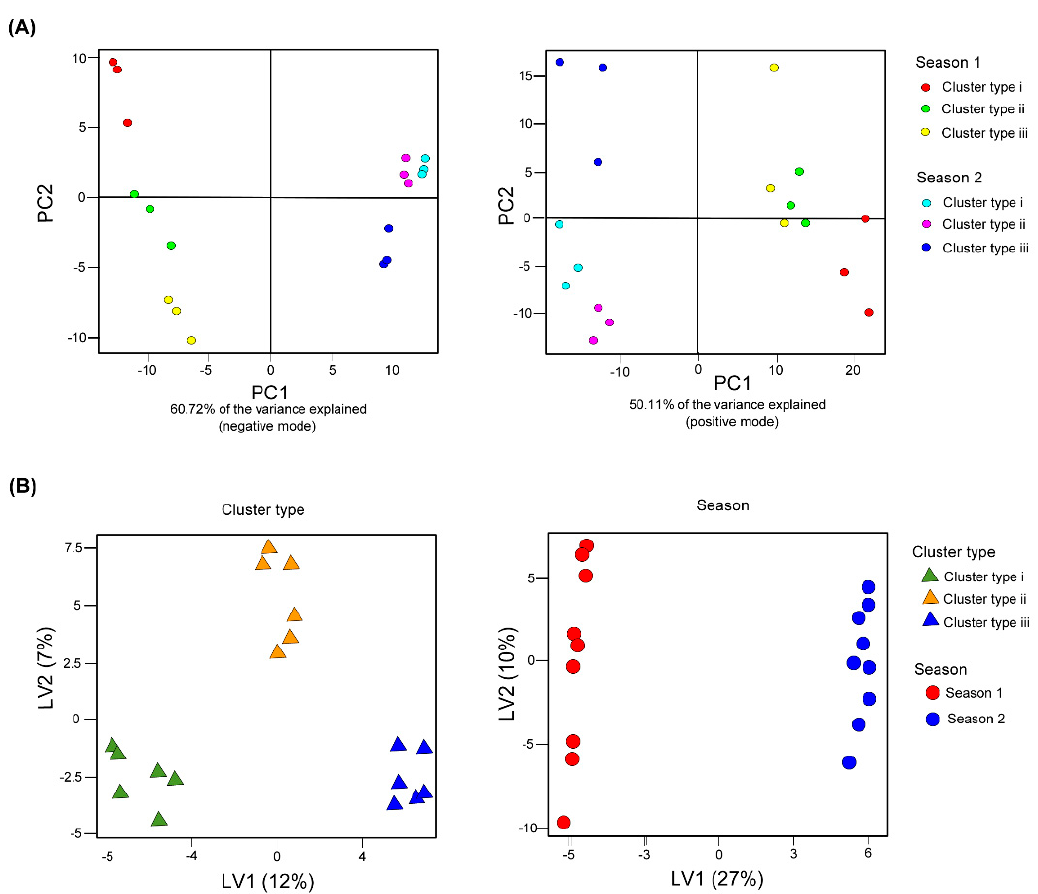
Figure 3. Score plots of all detected m/z features of the three Pinot noir wines from two different seasons in positive and negative mode investigated by ( A ) principal component analysis (PCA) and ( B ) the latent variables (LVs) in first discriminant analysis (sPLS-DA).